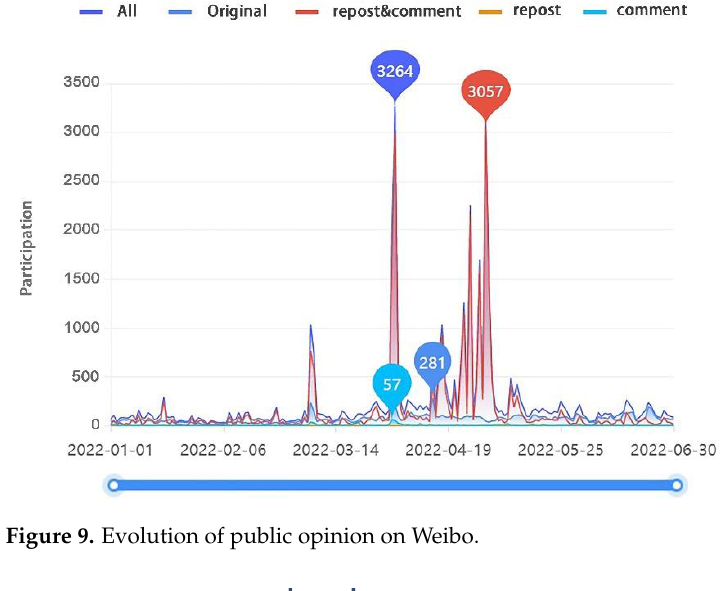
Figure 9. Evolution of public opinion on Weibo.